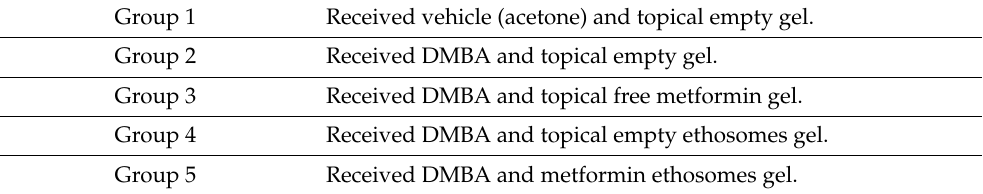
Table 4. Experimental groups for the in vivo mouse